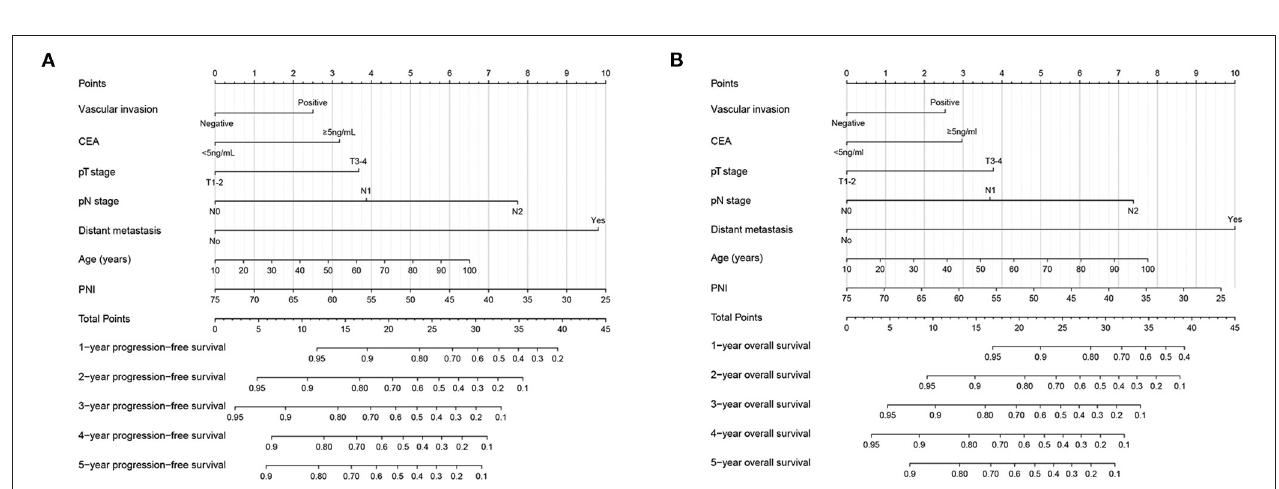
FIGURE 4 | Construction the novel prognostic nomograms in CRC patients. (A) PFS nomogram; (B) OS nomogram.